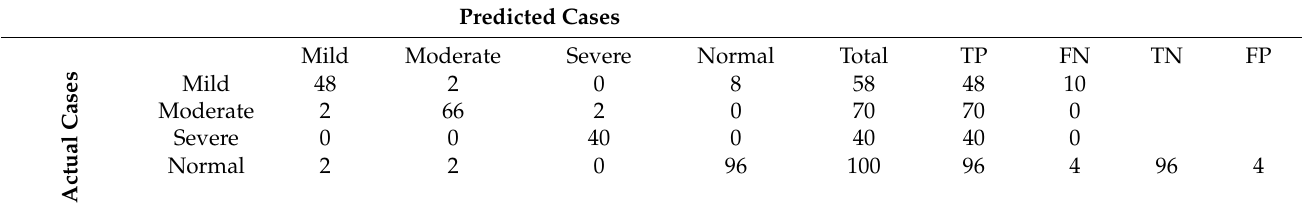
Table 5. Keratoconus detection confusion matrix.